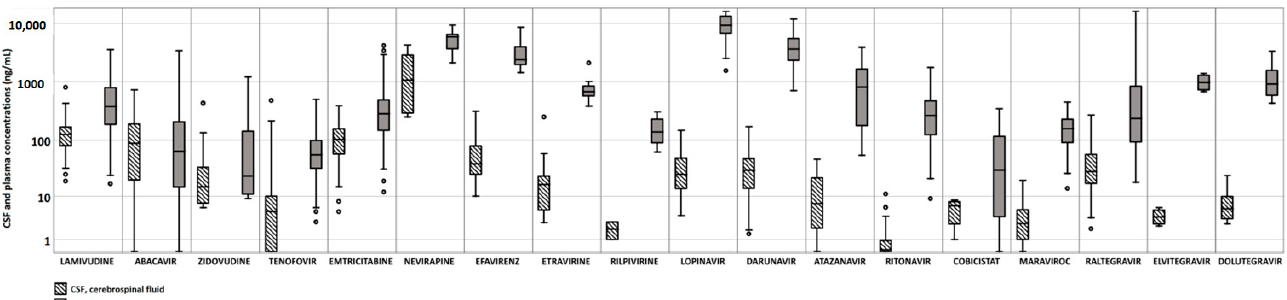
Figure 1. Cerebrospinal fluid and plasma concentrations of different antiretroviral drugs. The CSF/plasma ratio (CPR) was calculated for each drug and expressed as a percentage: ABC and AZT showed the highest CSF-to-plasma ratios (CPR) (92% and 97% CPR, respectively), followed by 3TC, FTC and NVP (37%, 39% and 45% CPR, respectively). All the other drugs showed very low CPRs (Figure 2).